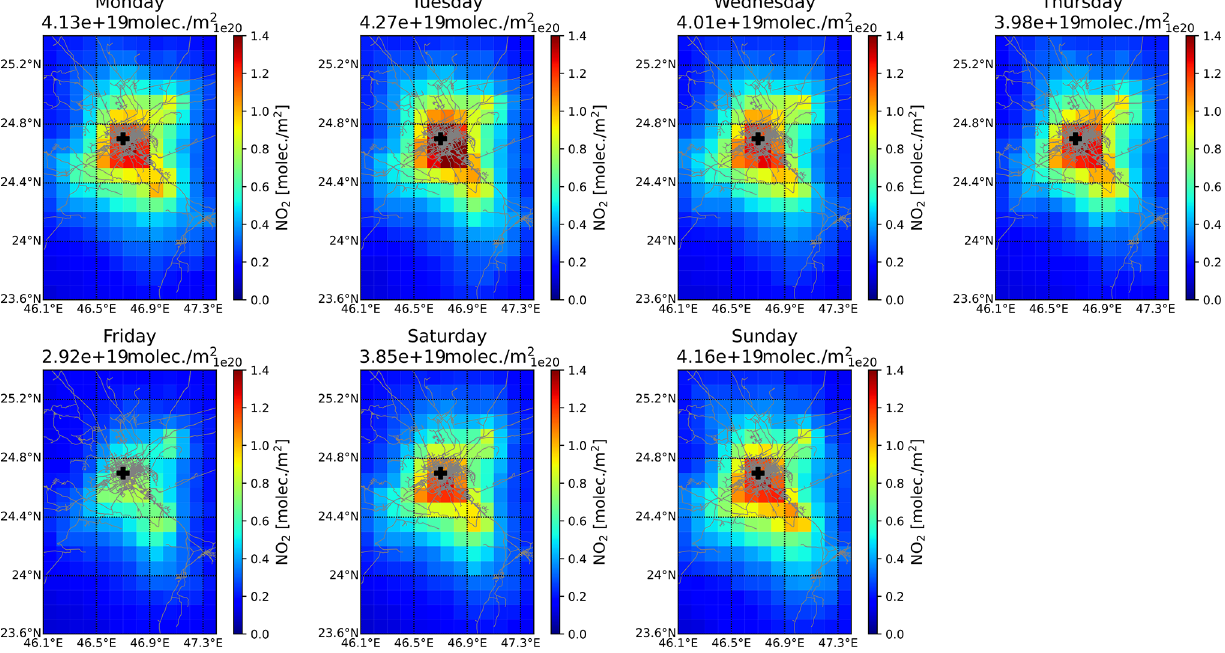
Figure A7. The TROPOMI tropospheric NO 2 column during the week in Riyadh. The number in the panel heading represents the average column abundance over the